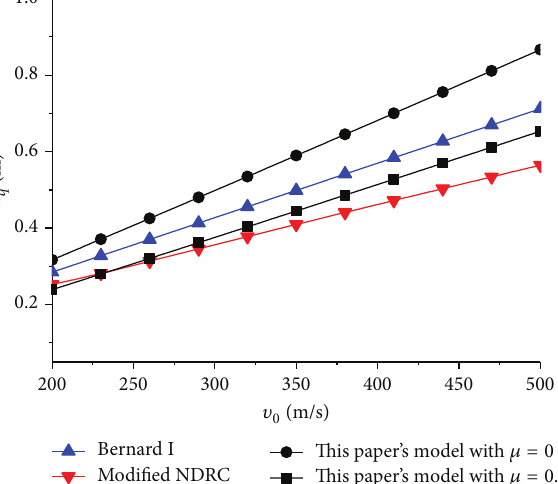
Figure 9: The predicted results for T-2 and